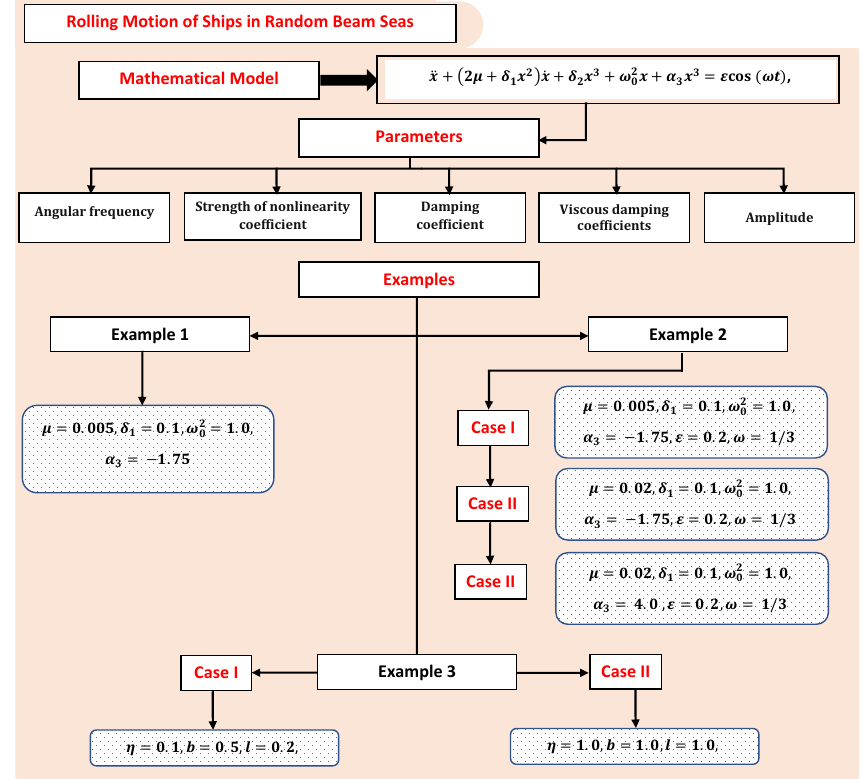
Figure 5. An overview of different examples and cases studied in this